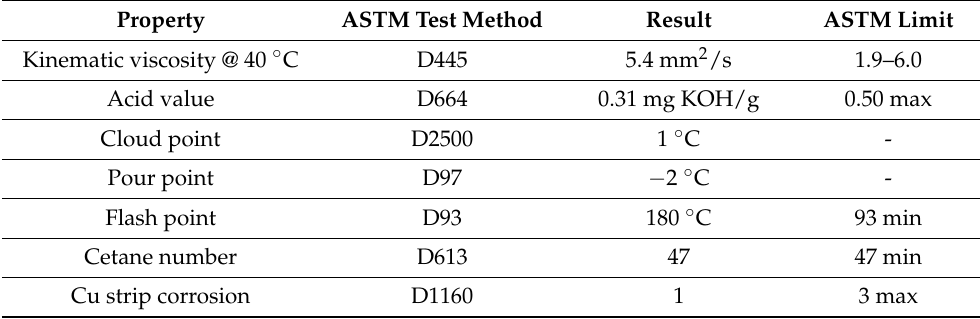
Table 8. The fuel properties of T. indica methyl